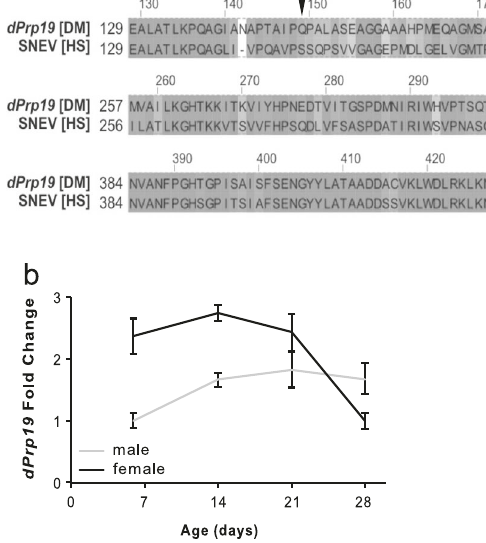
Fig. 1 dPrp19 is the Drosophila melanogaster ortholog of human PRP19/SNEV/hPso4. a Prp19 is well-conserved from D. melanogaster to humans, as shown in an alignment of the protein sequences of D. melanogaster d Prp19 and human PRP19/SNEV/ h Pso4. The two orthologs have an amino acid identity of 66% and a sequence similarity of 81%. The human site of ATM phosphorylation, Ser 149 , is substituted for Gln in Drosophila (indicated by the black arrow ). b dPrp19 expression is higher in female D. melanogaster and decreases with age. Comparison of dPrp19 mRNA levels in male ( gray ) and female ( black ) wild-type fl ies at 6, 14, 21, and 28 days of adulthood shows that dPrp19 levels decrease in females between days 21 and 28. Values represent means across three biological replicates ( ± 1 standard deviation), normalized to Gapdh2 and Tubulin and